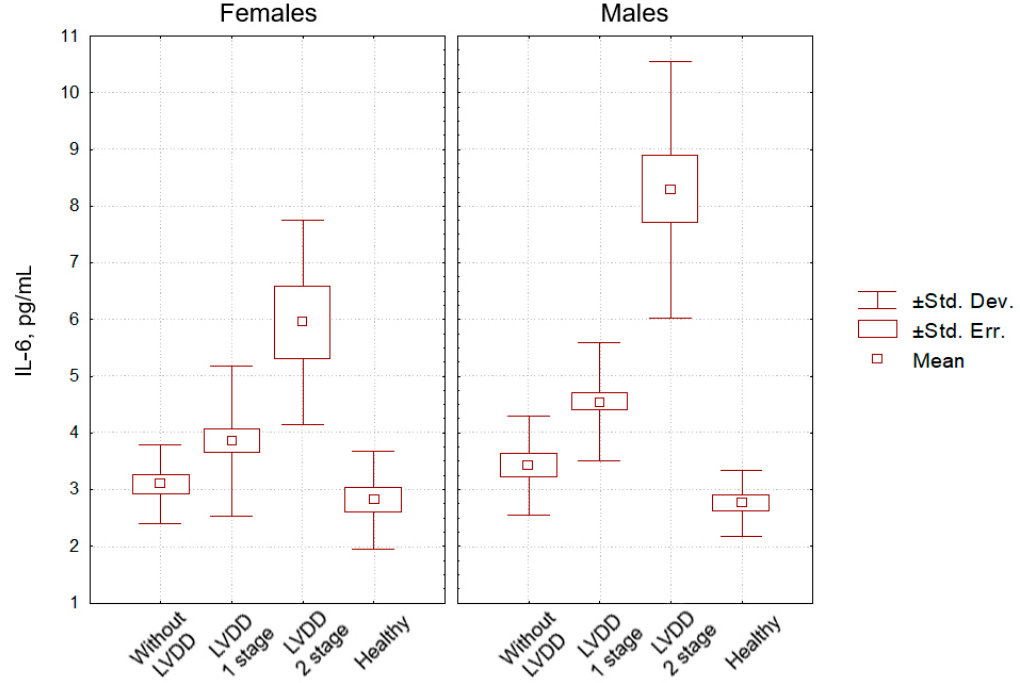
Figure 5. Indicators of IL-6 level in the blood (pg/mL) in patients with hypertension without CHF and LV diastolic dysfunction (comparison group), patients with hypertension with CHF and LV diastolic dysfunction of the 1st and the 2nd stages, and healthy individuals (control group), taking into account participants’ gender. Both male and female patients with essential HTN complicated by HFpEF displayed significant negative correlations of the serum CRP, TNF- α , and IL-6 levels with the 6 min walk distance (males: r = − 0.568, p < 0.001; r = − 0.640, p < 0,001; r = − 0.616; p < 0.001; females: r = − 0.610, p < 0.001; r = − 0.513, p < 0,001; r = − 0.373; p = 0.001). Figures 6 and 7 depict the associations of proinflammatory mediators with exercise tolerance regarding gender.